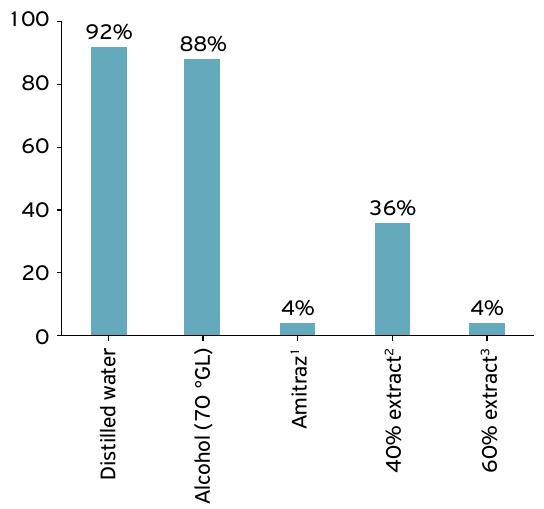
Figure 3. Percentage oviposition among the teleogynes of Rhipicephalus (Boophilus) microplus that were treated in vitro with distilled water, alcohol (70º), amitraz and 40 and 60% extracts of C. ambrosioides and maintained under biochemical oxygen demand (BOD) conditions at a temperature of 27ºC ( ± 1) and 80% relative humidity ( ±